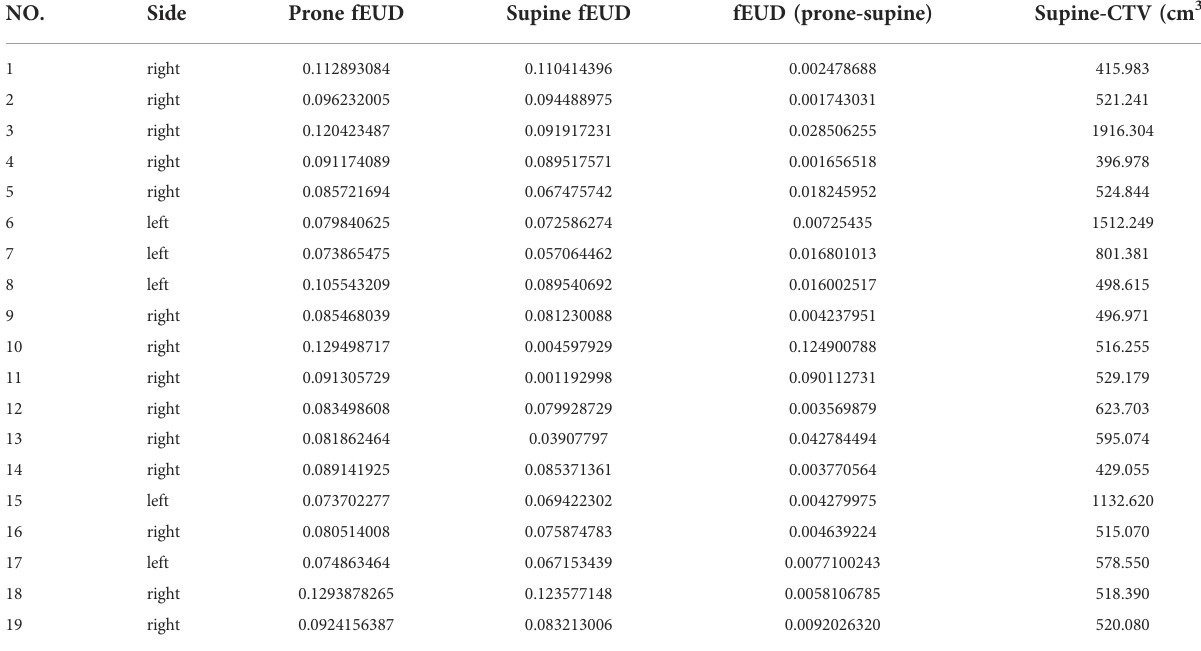
TABLE 3 fEUD values for prone plans superior to supine